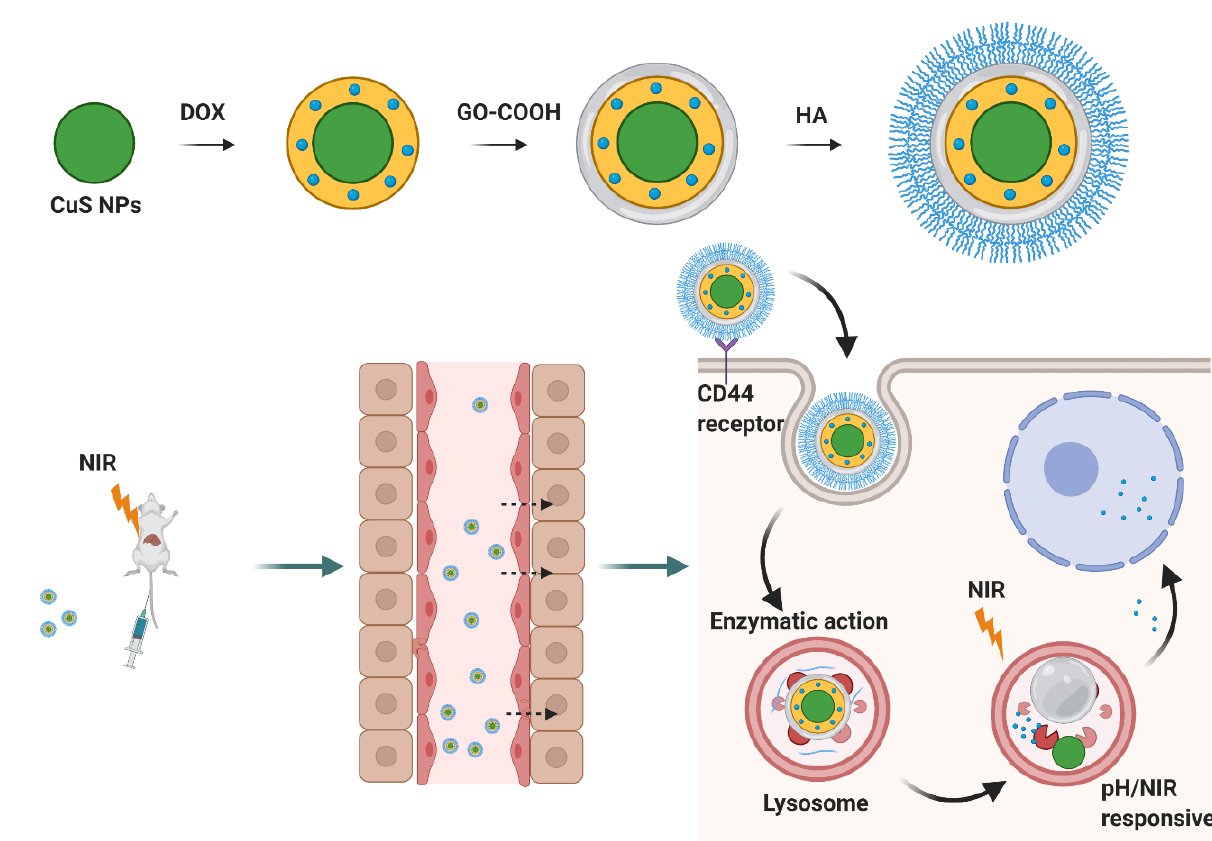
Figure 11. NIR and pH responses of hyaluronic acid nanogels.